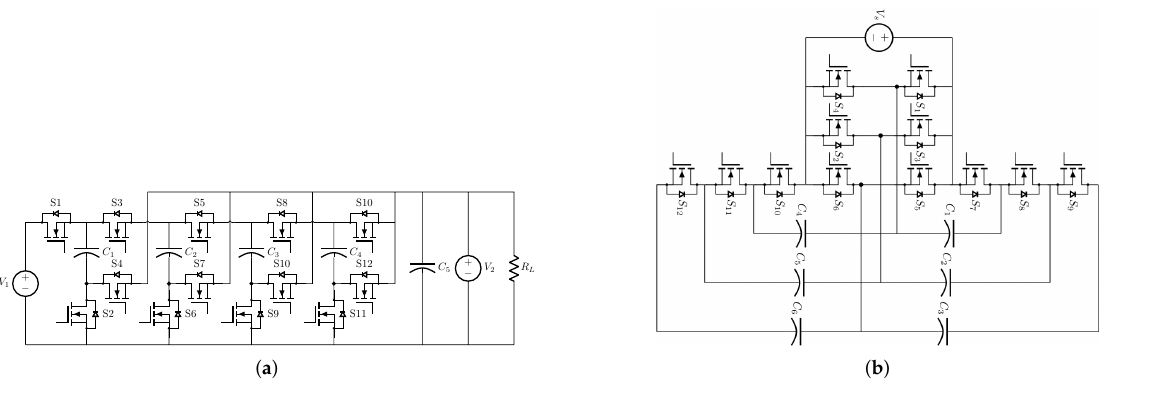
Figure 8. ( a ) Multilevel Modular Capacitor Clamped Converter (MMCCC) and ( b ) 6X Switched